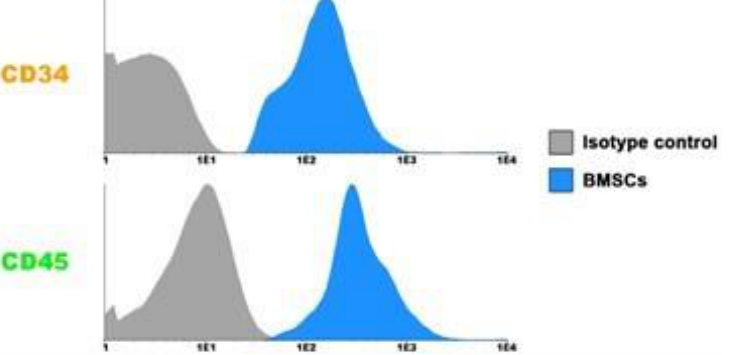
Figure 3. Characteristics of BMSCs. Flow cytometry Histograms of Bone marrow mononuclear cells. The histograms show that the population is positive for anti-CD45 and CD34.